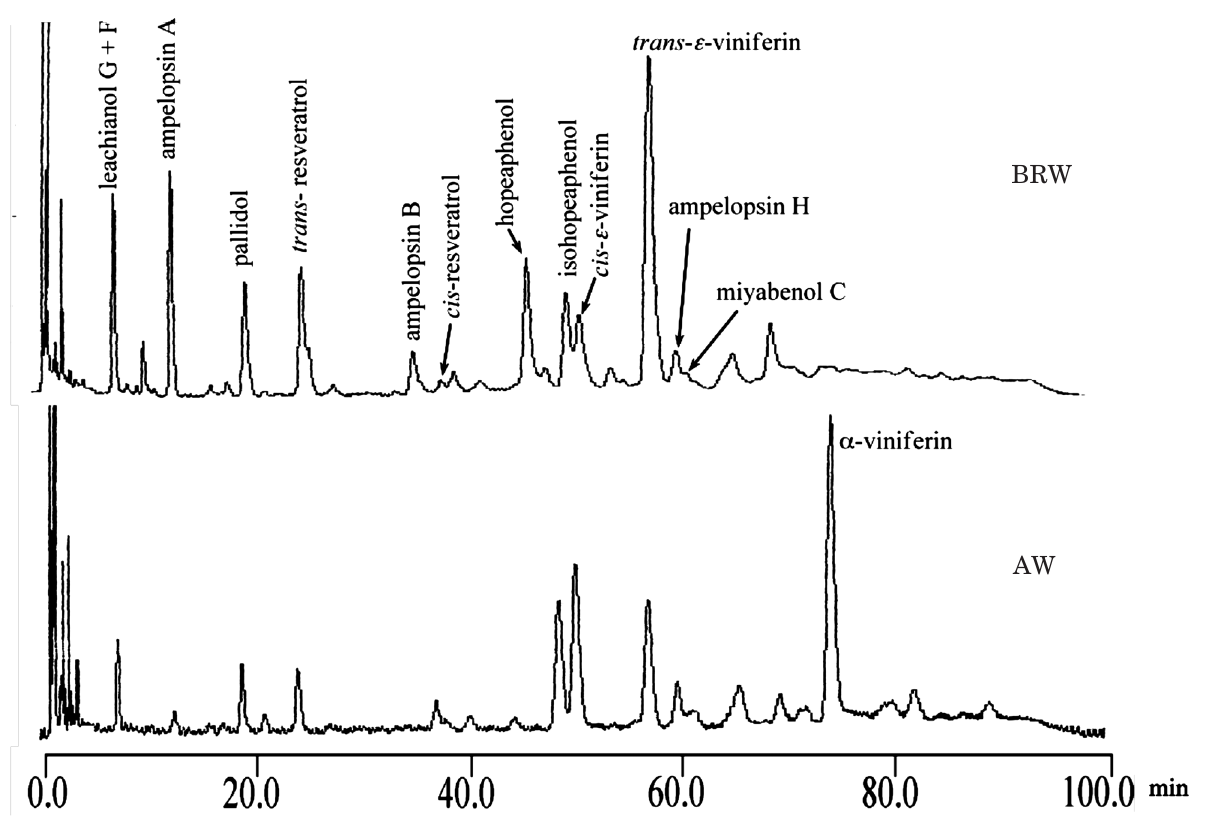
Figure 2. Chromatograms of methanolic extracts of brown-red wood (BRW) and asymptomatic wood